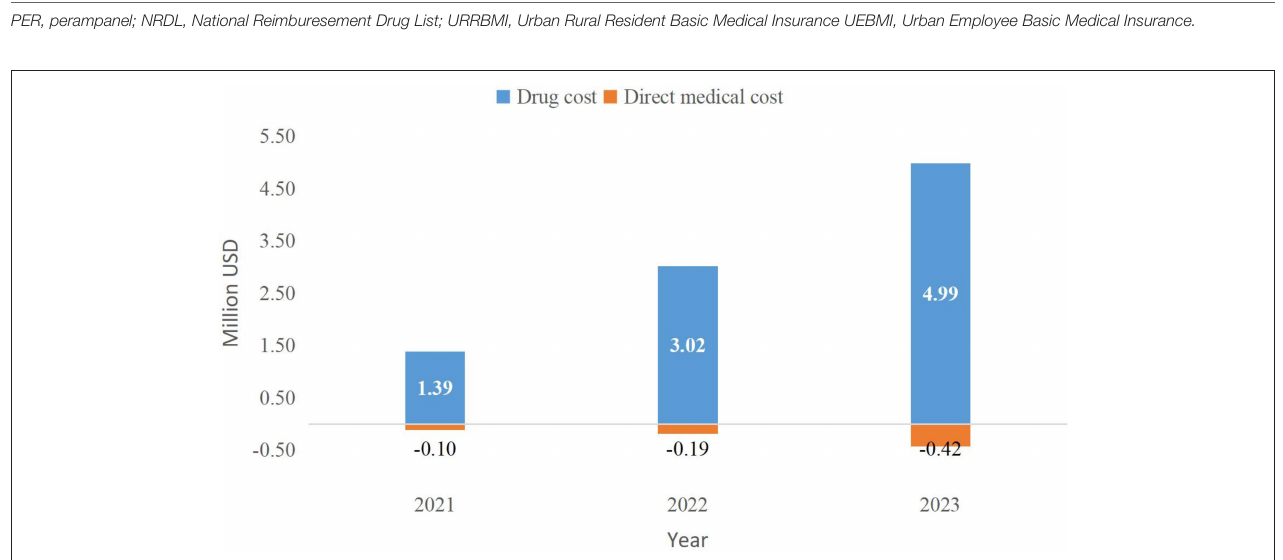
After the inclusion of PER in the NRDL